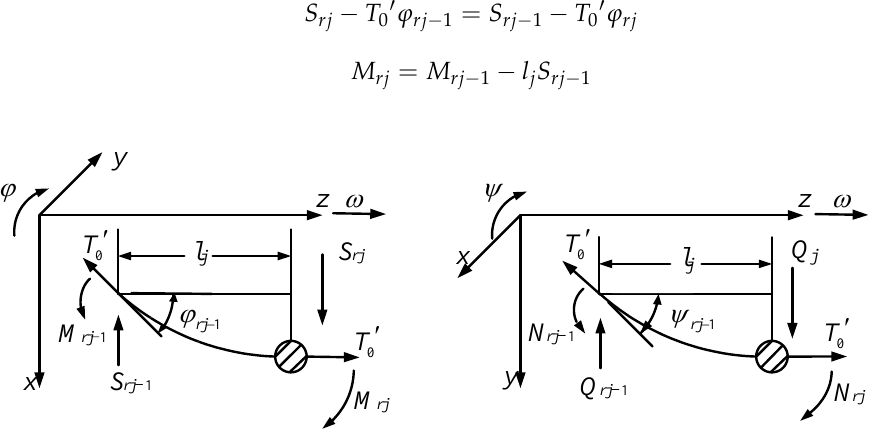
Figure 4. The force analysis of the j th tie rod shaft